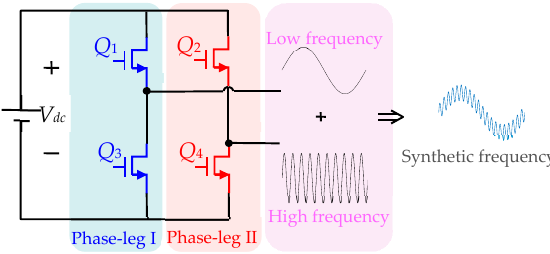
Figure 1. Topology of GaN-based single phase full bridge inverter.